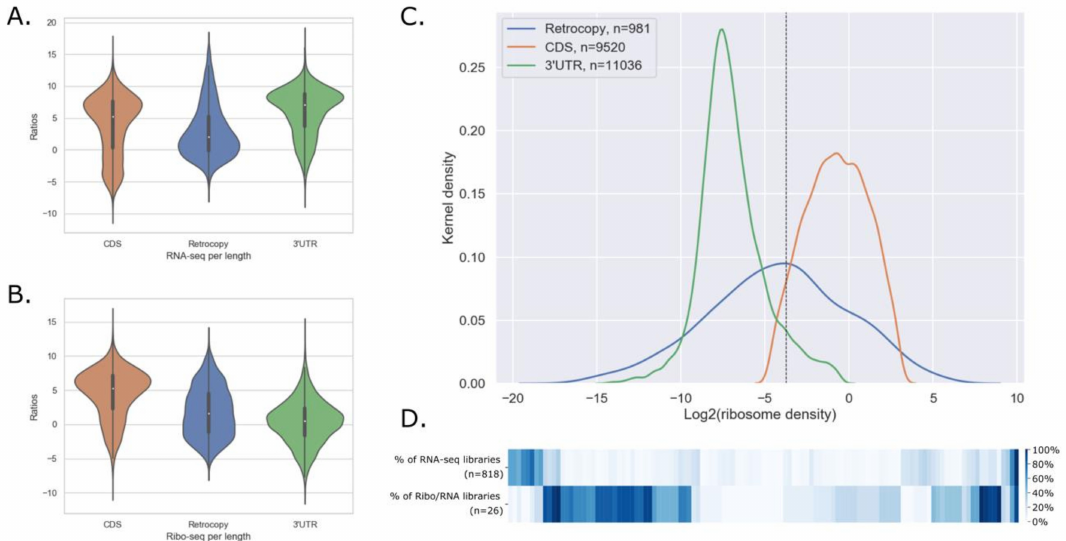
Figure 4. (A) Violin plot for RNA-seq coverage for coding sequences, 3 (cid:48) UTRs of protein-coding genes, and retrogenes in lymphoblastoid cell line as an example. ( B ) Violin plot for Ribo-seq coverage for coding sequences, 3 (cid:48) UTRs of protein-coding genes, and retrogenes in lymphoblastoid cell line. ( C ) Kernel density distribution of ribosome density in lymphoblastoid cell line; dotted black line marks the cut o ff level calculated based on Z-score of 1.64 in 3 (cid:48) UTR group. ( D ) Heatmap for 117 retrocopies that have a positive signal from expression analysis in 818 ENCODE samples, peptide analysis and ribosome density